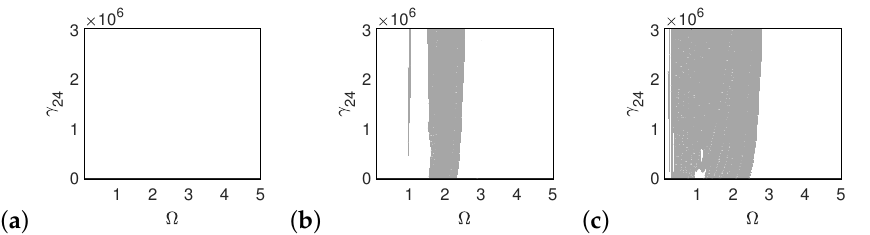
Figure 8. Regions of polyharmonic vibrations of the can for the case of the normal ear versus the nonlinear stiffness rate of the coupler ( γ 24 ) and the excitation frequency ( Ω ) under the excitations p ( a ), 5 p ( b ) and 10 p ( c ).